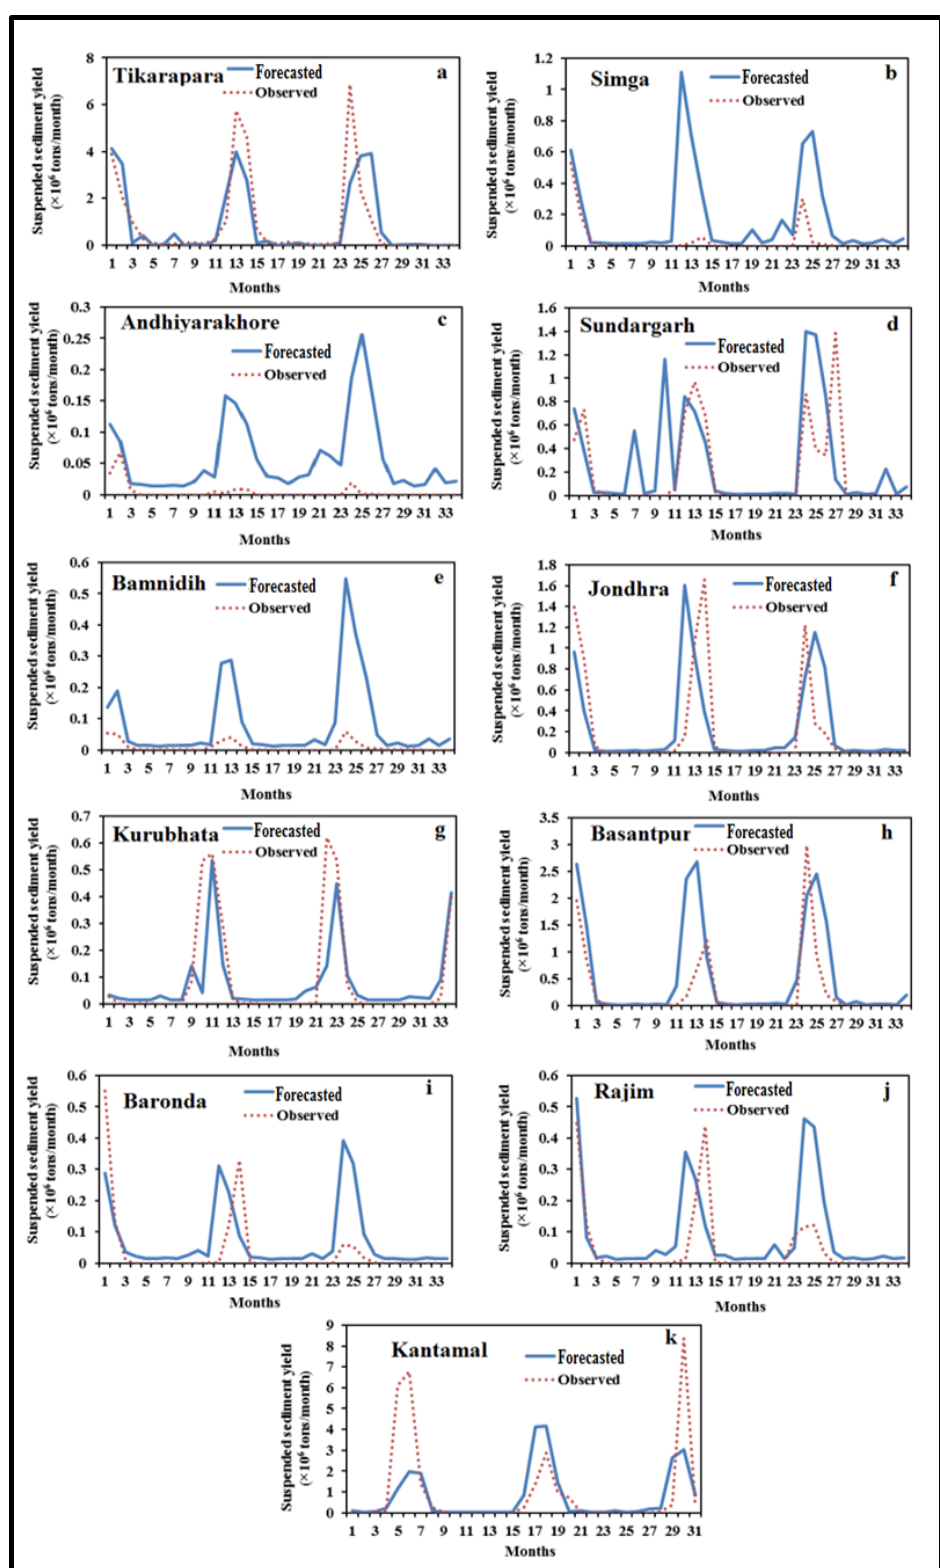
Figure 6. Comparison of the forecasted and observed SSY of the GA-ANN-51 forecasting model in a testing phase (a-k).